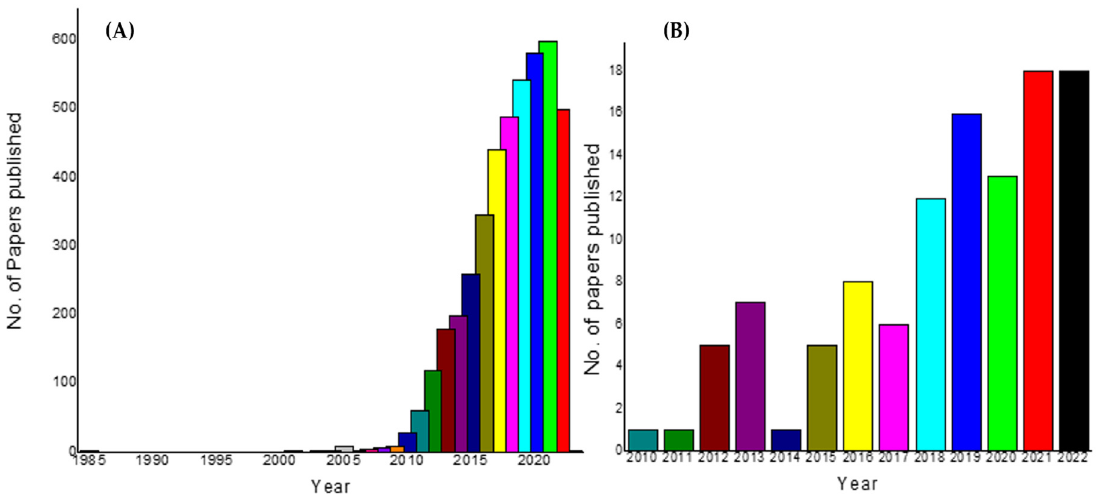
Figure 4. Results from a PubMed search using the terms ( A ) graphene and energy storage and ( B ) graphene polymer nanocomposites and energy storage.